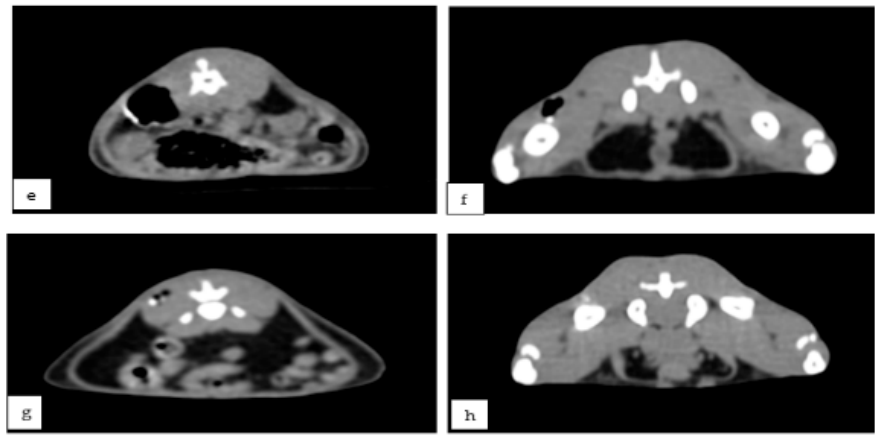
Figure 3. Rat, post-operative representative CT images, Mg-0.5Ca-xY alloy and gas inclusions, lumbar spine ( a , c , e , g ) and femur ( b , d , f ) regions. After 1 week ( a , b ), 2 weeks ( c , d ), 4 weeks ( e , f ), and 8 weeks ( g , h ).